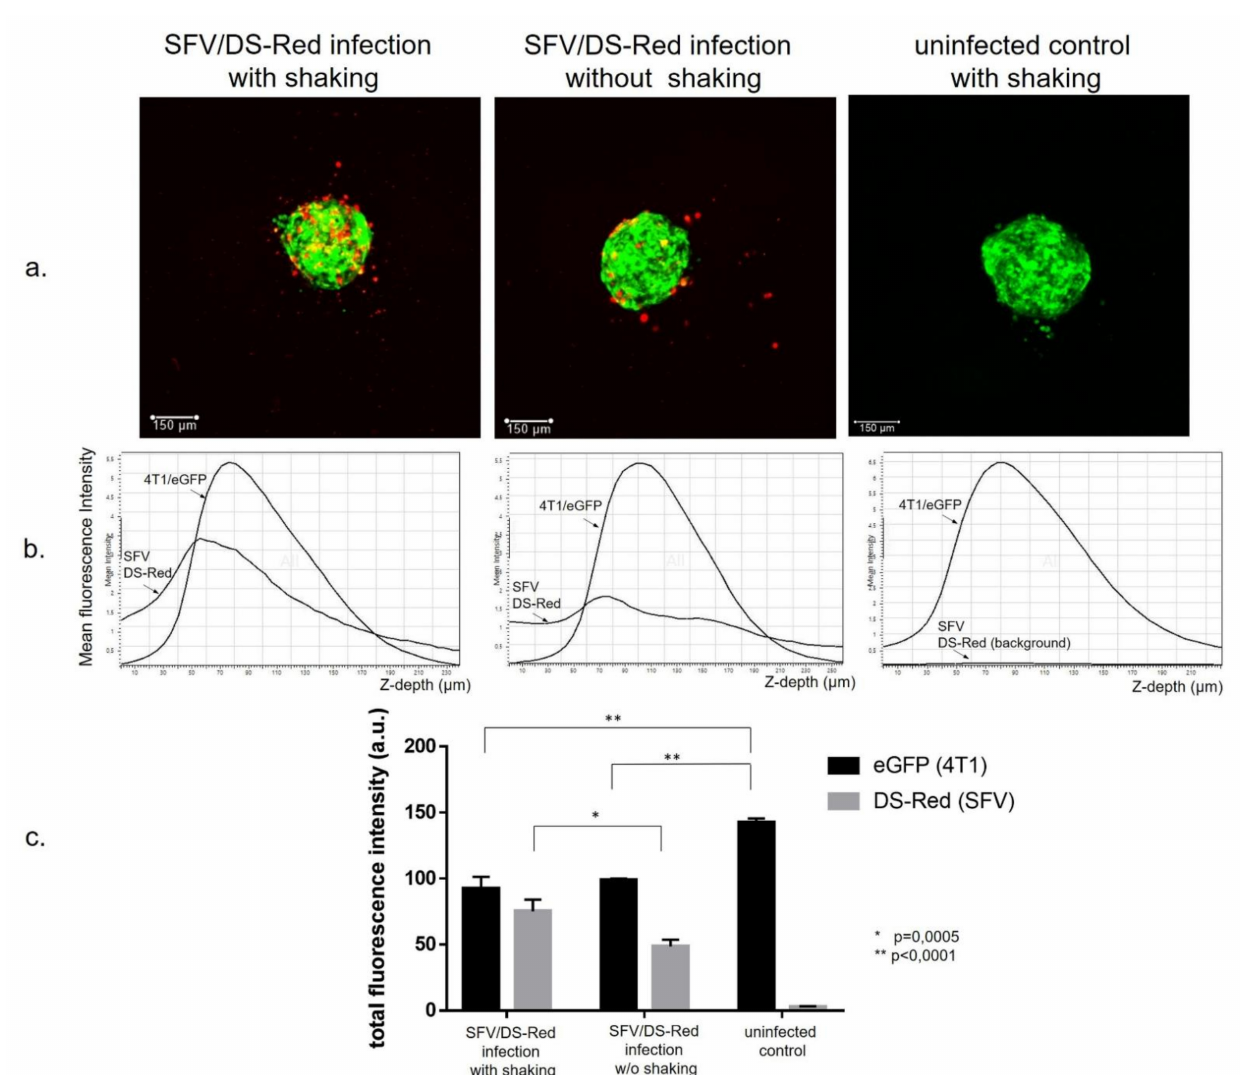
Figure 1. Infection of the 4T1/eGFP cancer cell spheroids with recombinant SFV/DS-Red virus. The 4T1/eGFP cells (3 × 10 3 cells per well) were plated into 96-well ultralow attachment plates. The next day, the spheroids were infected with SFV/DS-Red virus (10 5 i.u./well) either with or without shaking during incubation with the virus (1 h 10 min). Then, the spheroids were incubated for 2 days to allow DS-Red transgene expression. Confocal microscopy was performed using a Leica TCS SP8 microscope, and the images were processed by LasX software as described in the methods. ( a ) Maximum intensity projection confocal images of the 4T1/eGFP spheroids infected with SFV/DS-Red virus (representative images). ( b ) Graphical analysis of the mean fluorescence intensity changes from the spheroid upper rim to the spheroid bottom. The eGFP and DS-Red signal curves are indicated by arrows; 48 planes, z step 5 µ m. ( c ) Total fluorescence intensity of the spheroids incubated with or without shaking during infection and the uninfected spheroid controls. Data are presented as the mean of total fluorescence of four spheroids in each group. Error bars represent the standard deviation, n = 4. Statistical analysis was performed by Tukey’s multiple comparison